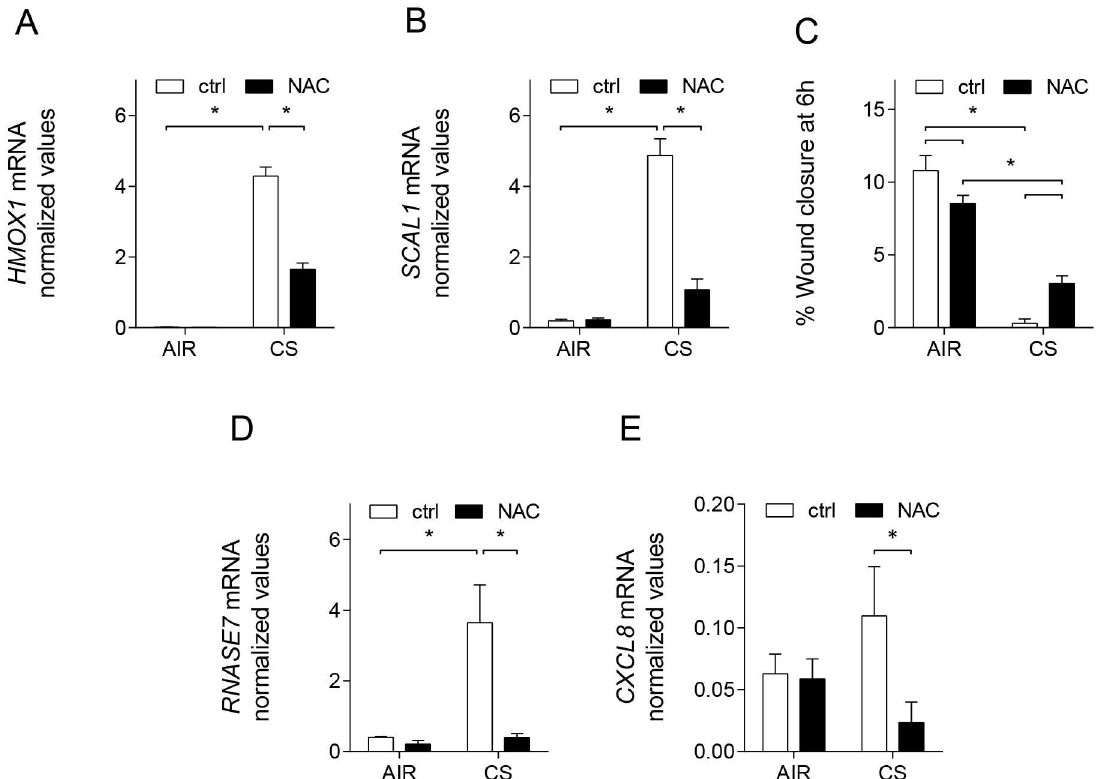
Fig 4. Role of CS-induced oxidative stress in modulating airway epithelial repair and innate immunity. Wounded ALI-PBEC were pre-incubated with NAC (10 mM) and subsequently exposed to air or CS. mRNA expressionof the oxidative stress-induced genes (A) HMOX1 and (B) SCAL1 was determined 6 h after exposure.Values shown represent normalized mRNA expressioncompared to RPL13A and ATP5B . n = 3 independent donors, * p < 0.05. (C) Wound closure in presence or absence of NAC (10 mM) 6 h after wounding,in air- versus CS-exposed cells. Data are shown as percentagewoundclosure compared to t = 0 h. n = 7 independent donors. (D) mRNA expressionof RNASE7 and (E) CXCL8 was assessed in wounded ALI-PBEC incubatedwith NAC (10 mM), at 6 h after exposure to air or CS. Data are shown as normalized mRNA expression compared to RPL13A and ATP5B . n = 3 independent donors. In all graphs data are shown as mean; error bars represent SEM; experiments were conducted in duplicate; * p <